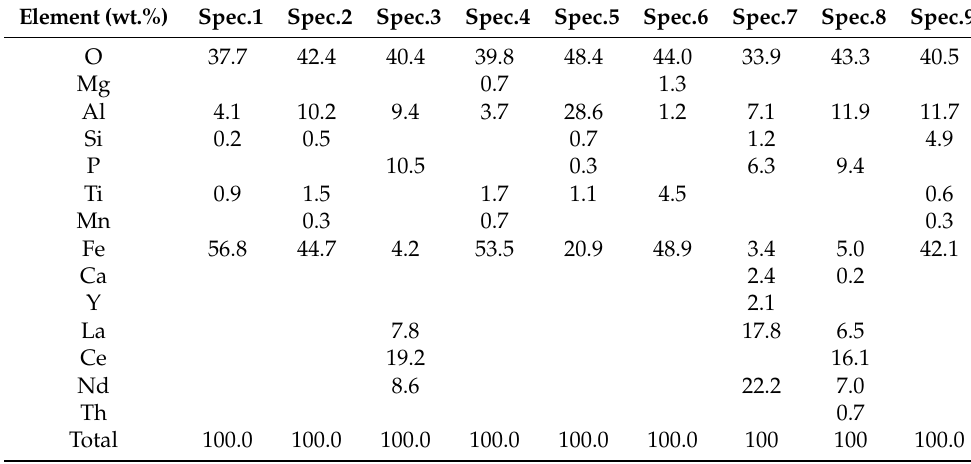
Table 6. Results of chemical analysis of points (sample 180, Figure 10). Element (wt.%)